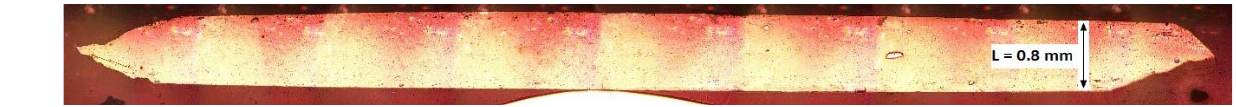
Figure 3. Optical micrograph taken on the cross-section of the HPT disk obtained after N = 5 rotations. The XRD patterns recorded on the surface of HPT disks exposed to uniaxial compression (MgNiCuY_CNT_0) and varying rotational strains (MgNiCuY_CNT_1, MgNiCuY_CNT_2, MgNiCuY_CNT_5 and MgNiCuY_5) are reported in Figure 4. Similar to the as-quenched glass, all deformed specimens possess the same amorphous halo centered at 2 θ ≈ 37 deg, amorphous background. The intensity of these peaks slightly increases with increased torsional straining; however, the amorphous component becomes dominant throughout